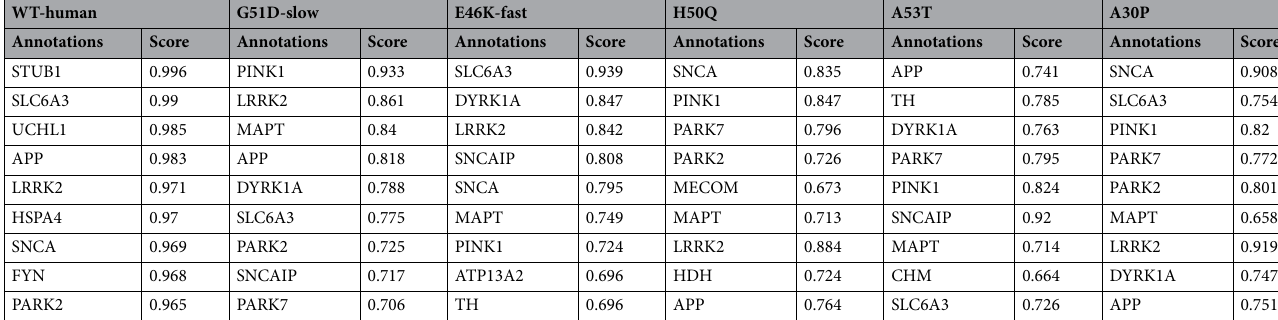
Table 1. The associating proteins of α -Synuclein for all the six sequential models are listed.